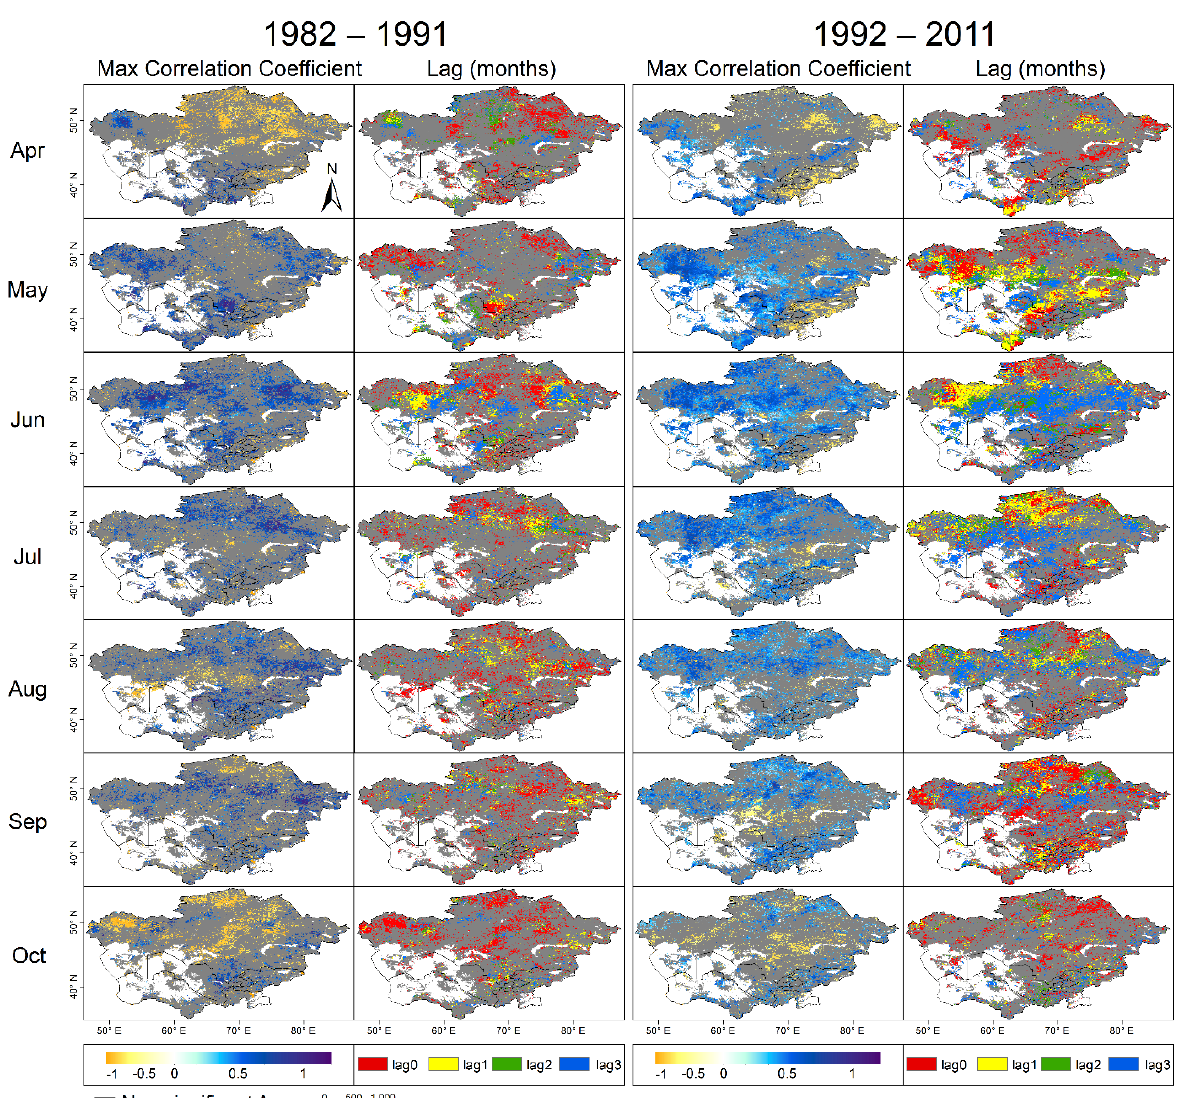
Figure 8. Lagged NDVI response to precipitation during 1982–1991 and 1992–2011. Maximum r corresponds to the maximum correlation coefficient for all correlation analyses between NDVI and precipitation in Central Asia. The resulting temporal lag represents the best fit for all time-lag correlation analyses. Areas with non-significant correlations ( p -value > 0.05) are shown in dark